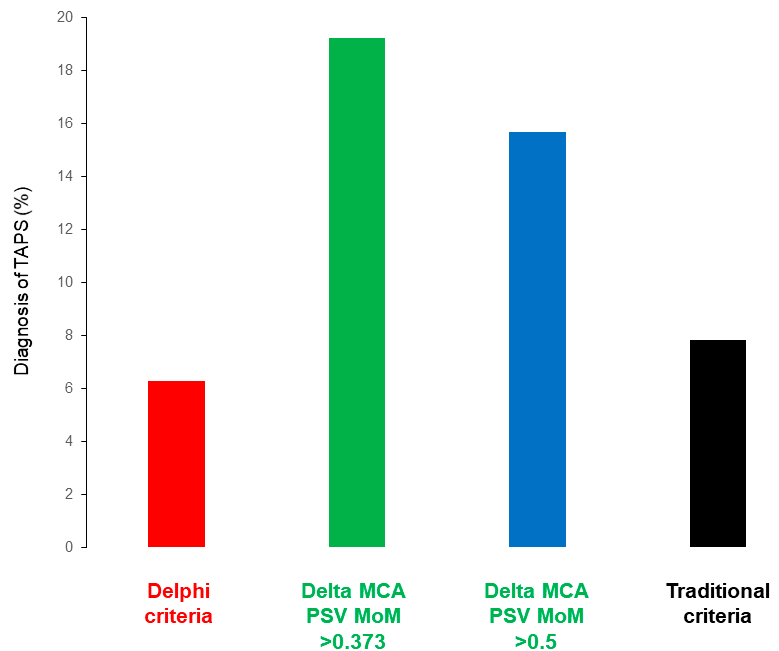
Figure 1. The antenatal incidence of twin anemia polycythemia sequence (TAPS) according to various diagnostic criteria. Delta peak systolic velocity (PSV) multiple of median (MoM)-based criteria increase the number of TAPS diagnoses compared to traditional criteria (Donor twin PSV MoM > 1.5 and Recipient twin PSV MoM < 1.0) and the newly proposed Delphi consensus criteria ( p < 0.001 for all). There were no significant di ff erences between the traditional criteria and Delphi consensus criteria ( p = 0.288, McNemar’s